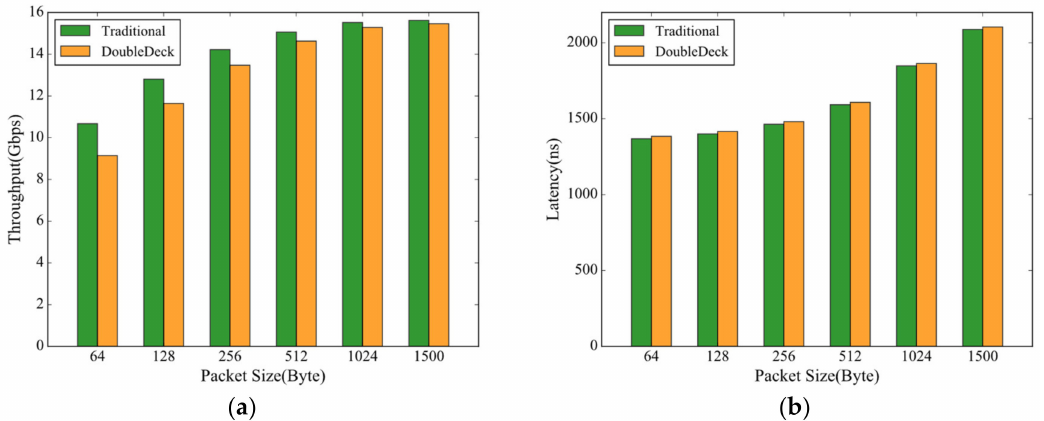
Figure 14. The performance comparison between traditional FSM method and DoubleDeck method. ( a ) Throughput comparison; ( b ) latency